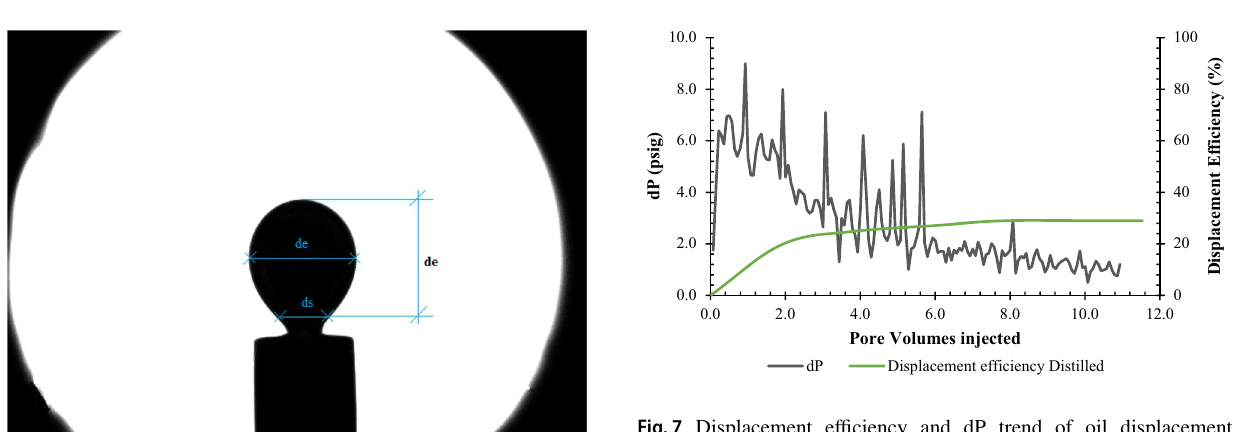
Fig. 7 Displacement efficiency and dP trend of oil displacement using distilled water